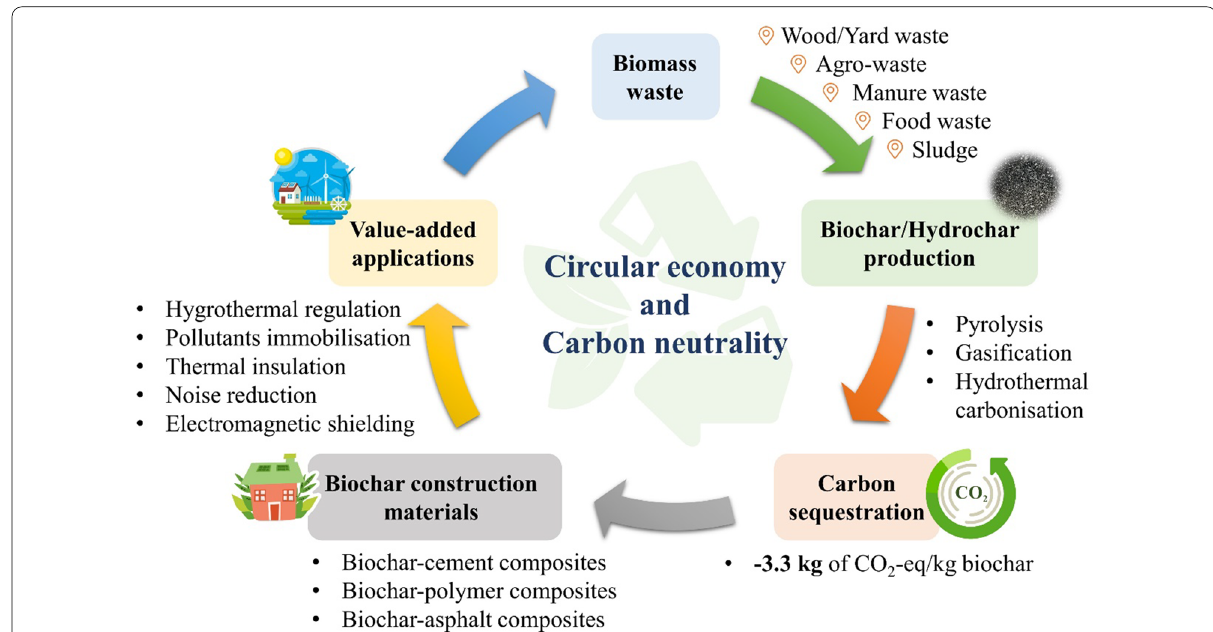
Fig. 1 Sustainable waste management towards circular economy and carbon neutrality by adopting biochar construction